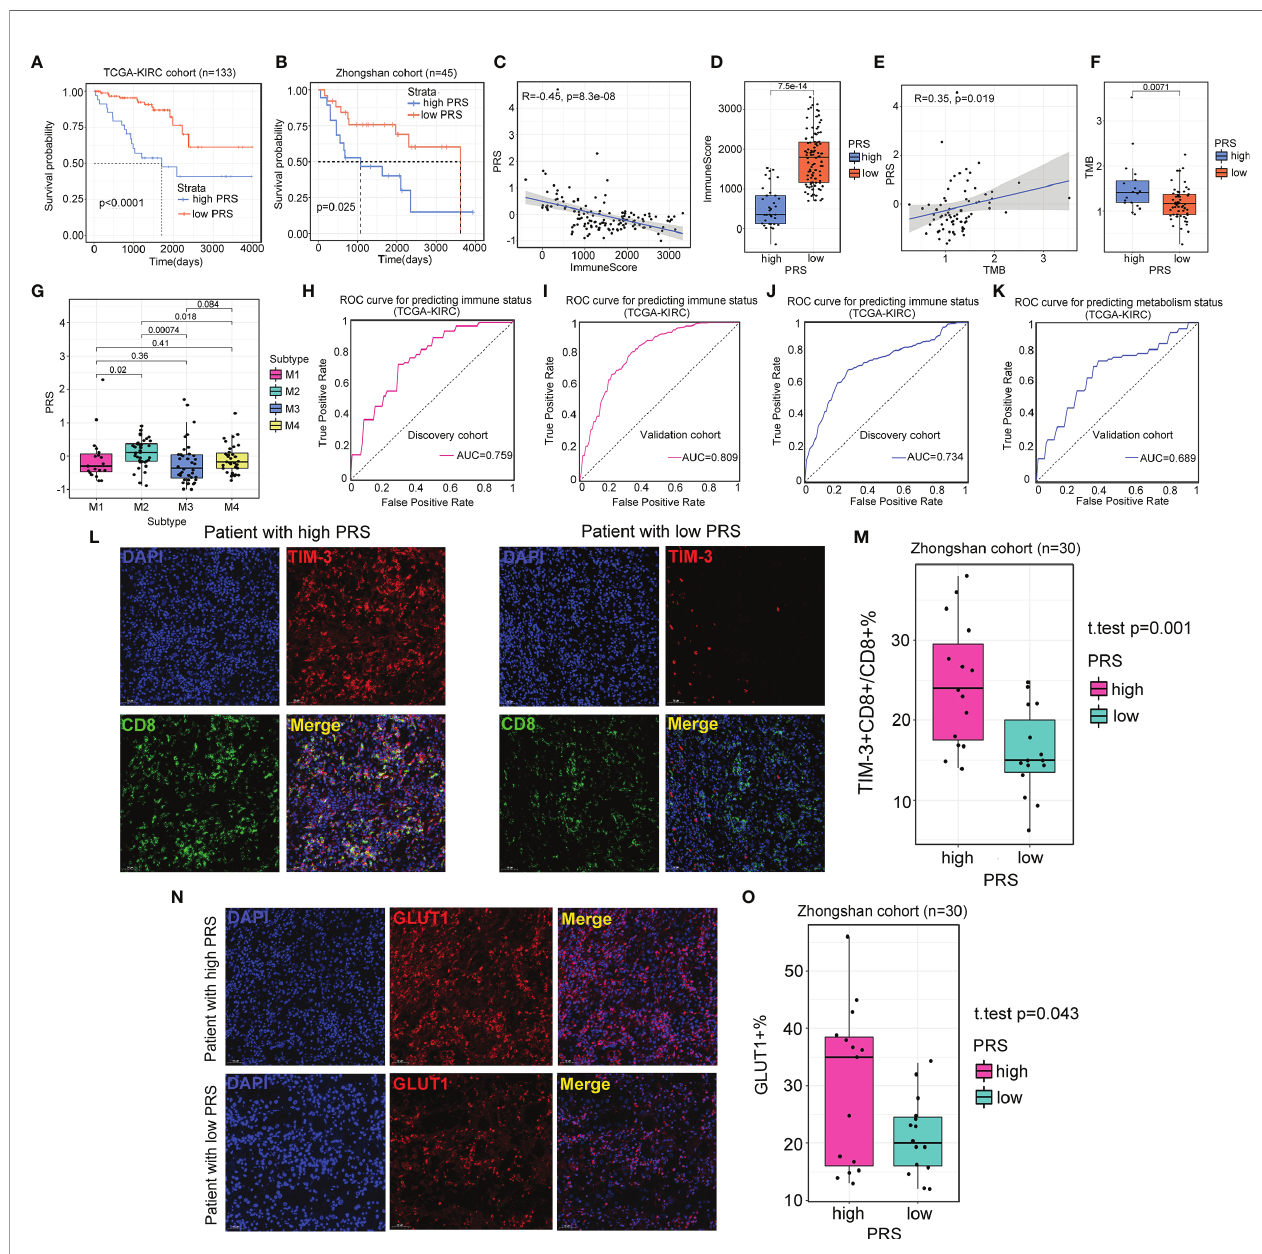
FIGURE 8 | Radiomics pro fi le reveals the status of immune and metabolism. (A, B) Survival analysis of patients from different prognostic radiomic score (PRS) groups in the TCGA-KIRC cohort (n=133) and Zhongshan cohort (n=45). (C, D) Scatter plot and boxplot show the correlation between PRS and immune score. For scatter plot, p -value is given by the Spearman correlation analysis. For boxplot, p -value is given by Wilcoxon rank-sum test. (E, F) Scatter plot and boxplot showing the correlation between PRS and TMB. For scatter plot, p -value is given by the Spearman correlation analysis. For boxplot, p -value is given by Wilcoxon rank-sum test. (G) The association between PRS and four immunometabolism subtypes. p -value is given by Kruskal – Wallis test. (H, I) Results of area under the curve (AUC) for the 10 radiomic features predicting immune status in the discovery cohort (TCGA-KIRC cohort, n=91) and validation cohort (TCGA-KIRC cohort, n=42). (J, K) Results of AUC for the 11 radiomic features predicting immune status in the discovery cohort (TCGA-KIRC cohort, n=91) and validation cohort (TCGA-KIRC cohort, n=42). (L) Representative images of the immuno fl uorescence staining with TIM-3 (red), CD8 (green), DAPI (blue), and Merge (double positive) on ccRCC tissues and their paired normal tissues from high and low PRS groups. Scans are imaged at 200 magni fi cation. (M) The percentage of TIM-3 expressed on CD8 + T cells is higher in high PRS group (n=15) than low PRS group (n=15). p -value is given by Student ’ s t-test. (N) Representative images of the immuno fl uorescence staining with GLUT1 (red), DAPI (blue), and Merge on ccRCC tissues and their paired normal tissues from high and low PRS groups. Scans are imaged at 200 magni fi cation. (O) The percentage of the expression of GLUT1 is more in high PRS group (n=15) than low PRS group (n=15). p -value is given by Student ’ s